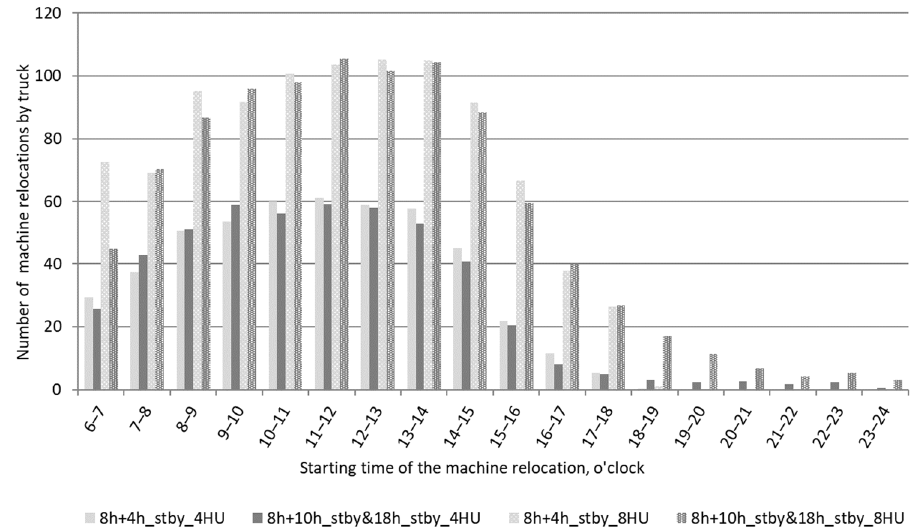
Figure 14. Distribution of starting times of machine relocations in each scenario run. The scenario bars represent averages of 7 replications. bars represent averages of 7 replications.